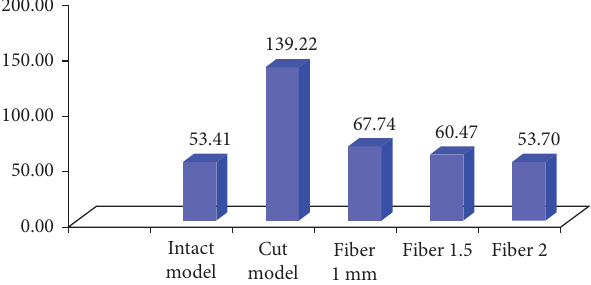
F IGURE 8: There is a nonsigni fi cant difference if we compare mean values between models 1 and 3 and their subgroups. The mean difference is highly signi fi cant with 95 % con fi dence and p -values < 0.05. Model 2 and the rest of Models 1, 3A, 3B, and 3C have similar mean